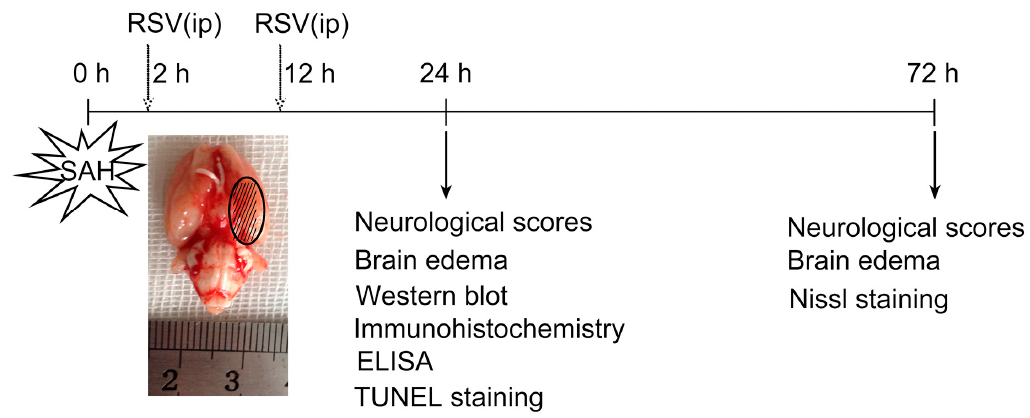
Figure 6. Schematic illustration of the experiment design. Resveratrol (RSV) was administered intraperitoneally (ip) at 2 h and 12 h after initial bleeding. In the first set of experiments, neurological scores, brain edema, Western blot analysis, immunohistochemistry, and TUNEL apoptosis were evaluated at 24 h after subarachnoid hemorrhage (SAH). In another set of experiments, neuronal survival, brain edema, and neurological function were evaluated at 72 h after SAH to determine the possible long-term benefits of